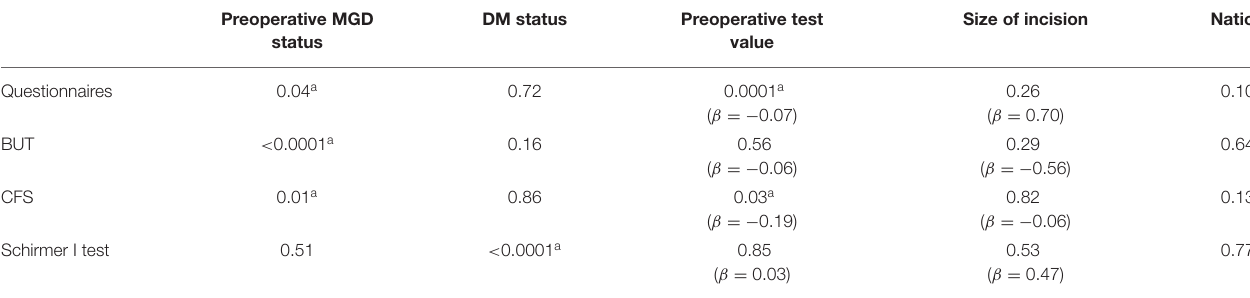
TABLE 4 | Interaction test analysis using